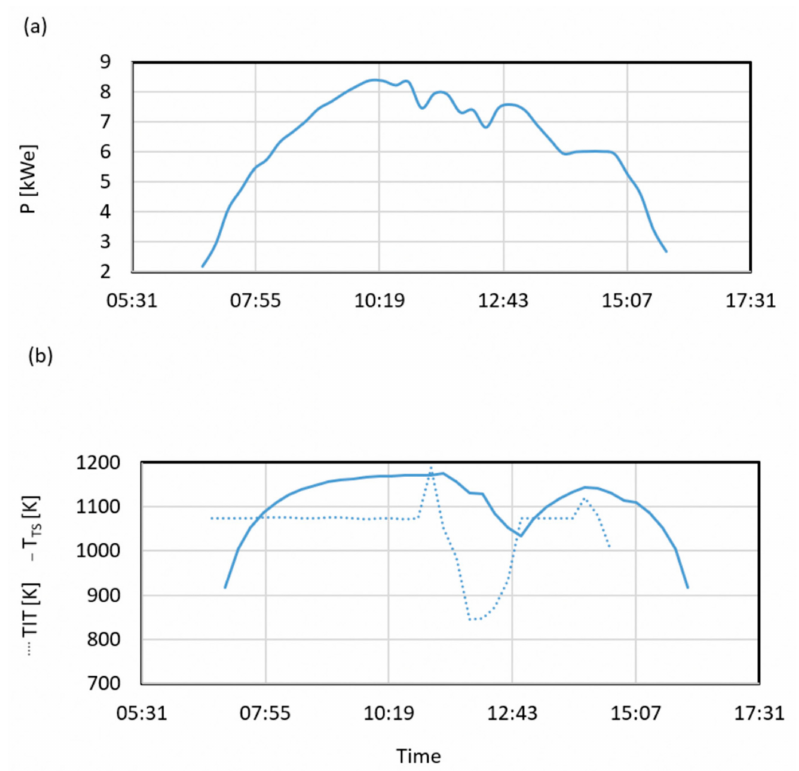
Figure 13. Performances of the plant during day 2: ( a ) Power output and ( b ) turbine inlet temperature (TIT) (dashed line) and storage temperature (continue